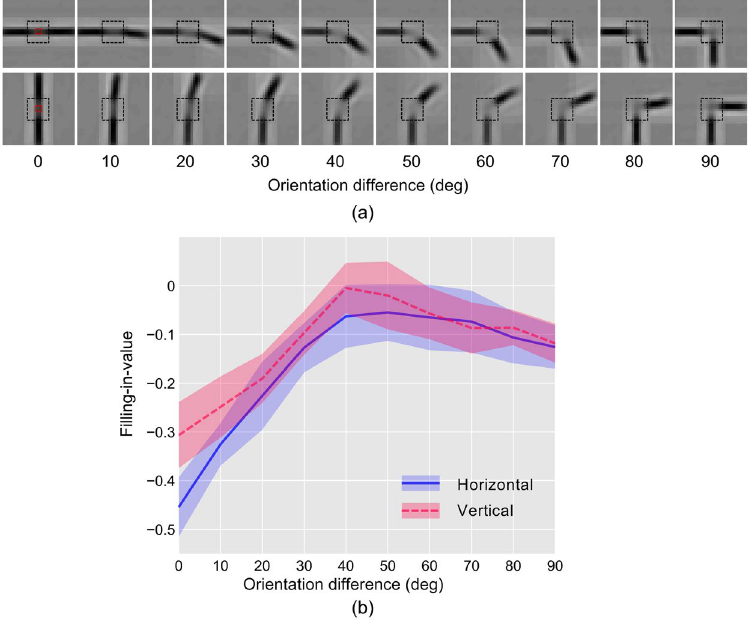
Figure 6. Anisotropy of tolerance in filing-in for disoriented bar. ( a ) Perceptually equivalent images are shown, which are generated from the response of PE neurons while the network was stimulated with stimuli depicted in Fig. 3c. ( b ) The plots of ‘filling-in-value’ in BS area of the images in ( a ) as a function of orientation difference between the bars are shown. Convention for lines and the shades are as described in Fig.